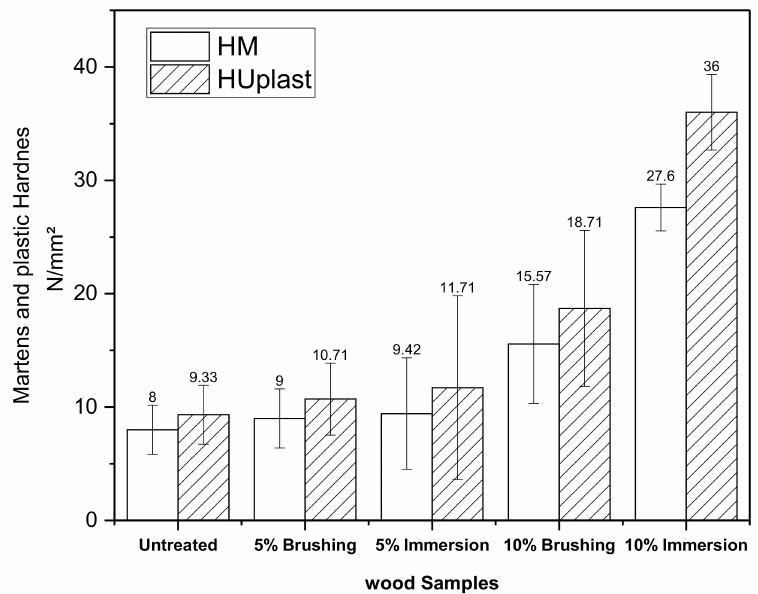
Figure 10. Martens hardness (HM) and plastic hardness (HU plast ) for wood